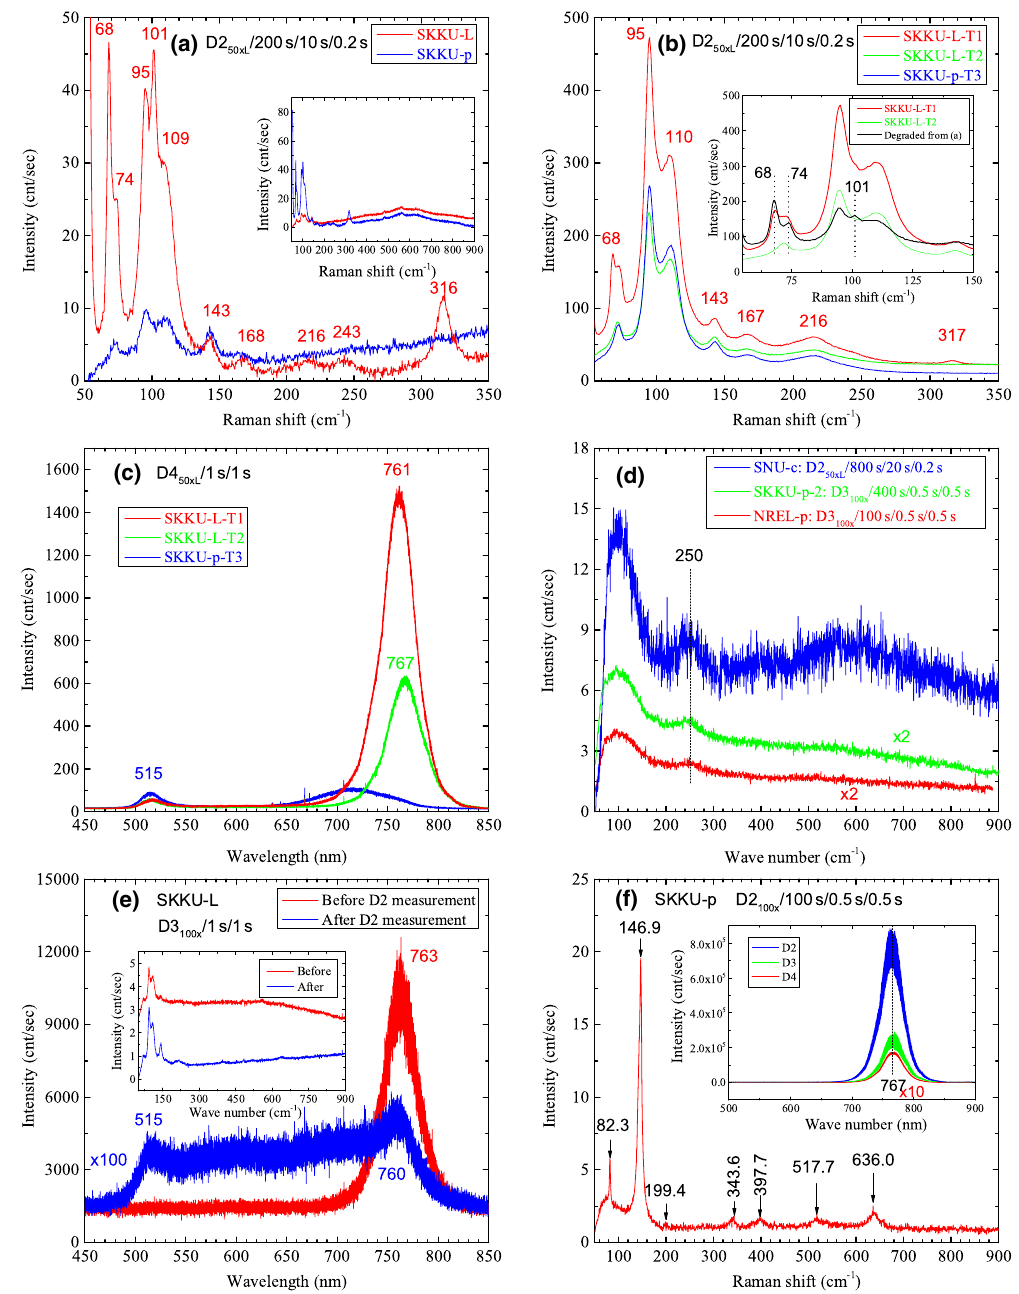
FIG. 8. Raman and PL spectra of partially or fully degraded samples. (a) Comparison of partially photodegraded SKKU sample between large and small domain (the inset shows the spectra in a larger spectral range). (b) Nearly fully degraded SKKU samples (including two distinctively different large domains), and the inset shows the spectra in a smaller spectral range. (c) PL spectra of the samples shown in (b). (d) The effect of photoinduced structure transformation in an already partially degraded sample due to the course of nature, showing a common Raman peak at around 250 cm − 1 . (e) PL spectra of a partially degraded SKKU-L sample measured before and after high-excitation density Raman measurement (the inset shows the corresponding Raman spectra). (f) Raman and PL spectra of an atypical location in a SKKU-p